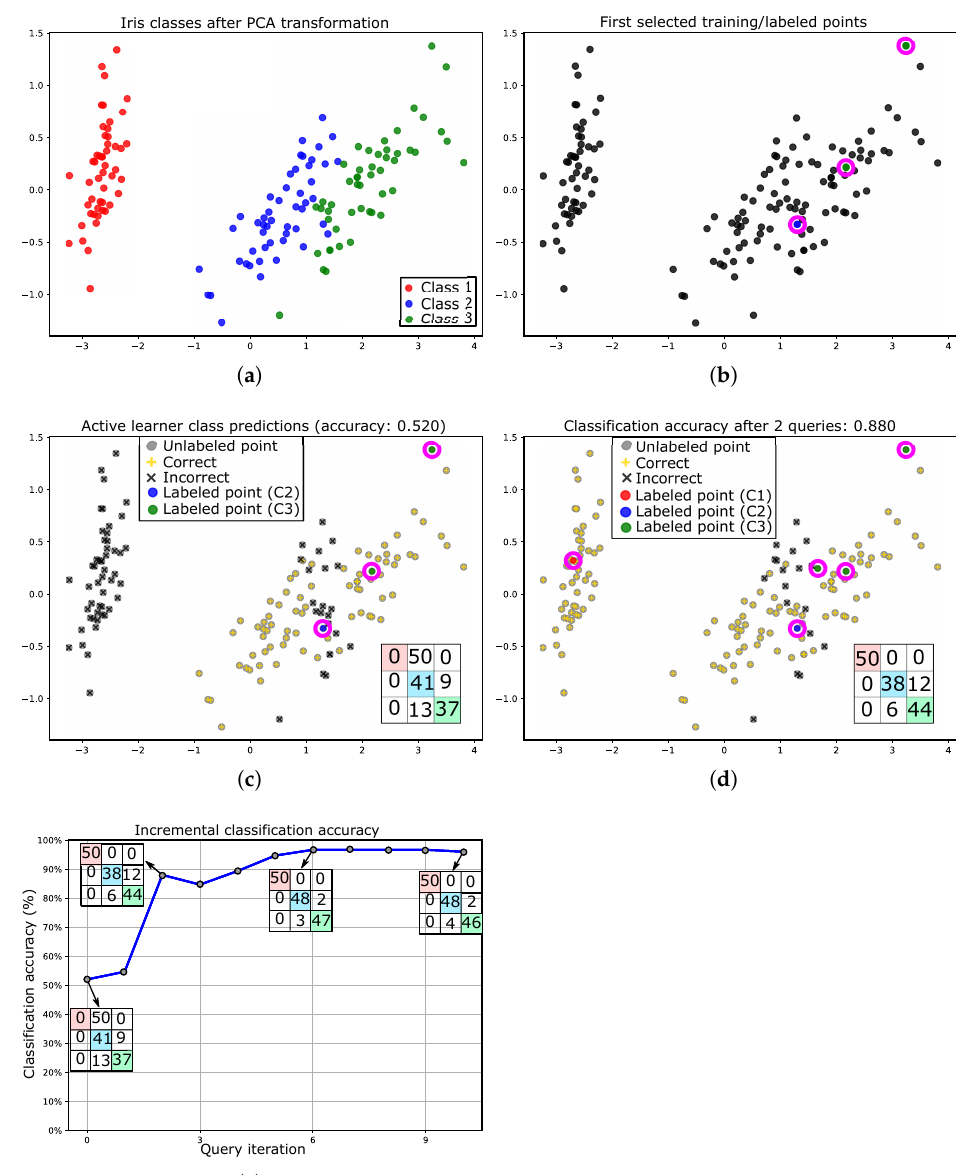
Figure 1. Visualization of our active learning example. ( a ) The original data with three classes, each with a different color. ( b ) The unlabeled data are in black color and the initial training/labeled data are the highlighted points with pink circles. ( c , d ) The correctly and incorrectly classified points of the trained model on three and five training points (i.e., initially and after querying two points), respectively. ( e ) The classification accuracy during the annotation